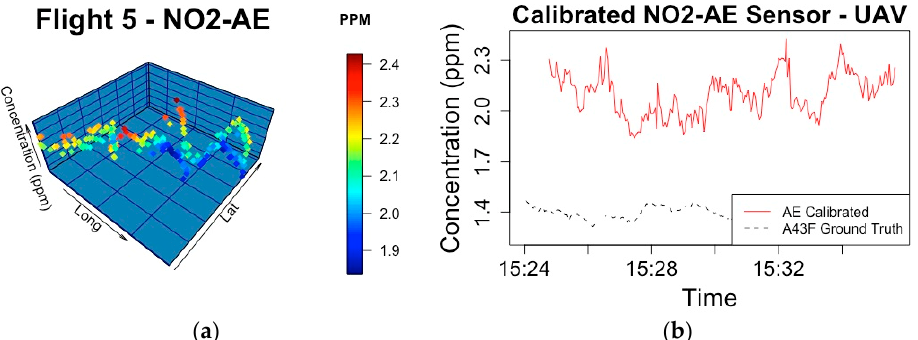
Figure 6. ( a ) Flight path and ppm concentration during Flight 4 of Stage B during Phase 3 of calibrating electrochemical sensors, where the NO 2 -A43F sensor is mounted on the UAV; ( b ) The calibrated sensor concentration is compared to the ground truth concentration.